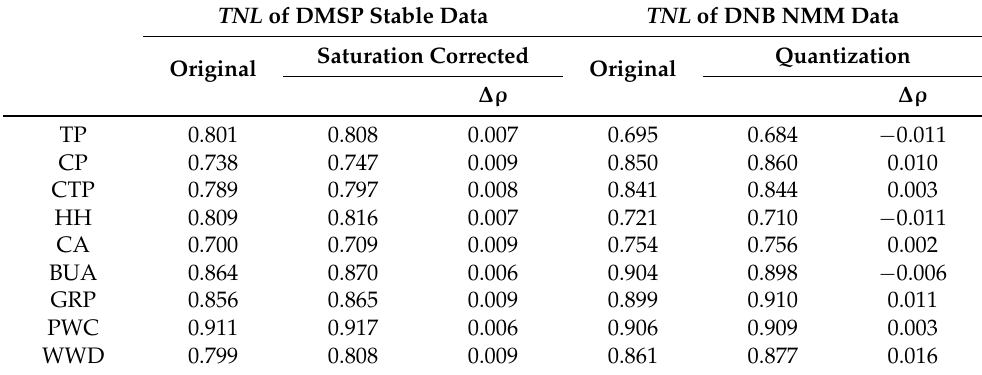
Table 9. Correlations between socio-economic parameters and TNL of DMSP stable data, TNL of ∆ ρ : difference in the comparison with the correlation derived from TNL of DMSP stable data and DNB NMM,